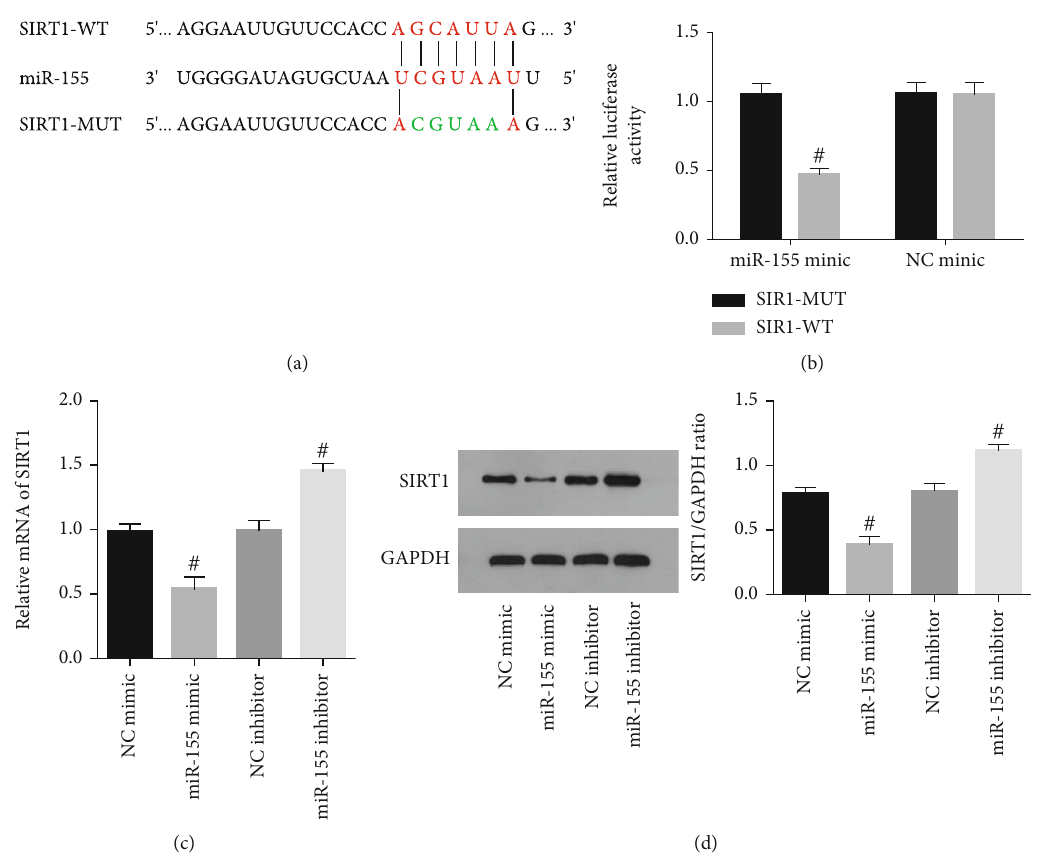
Figure 3: miR-155 directly targeted SIRT1 in podocytes. (a) miR-155 binding site speci fi c for SIRT1. (b) Luciferase activities of HEK-293T cells that overexpressed miR-155 along with either WT-SIRT1 or MUT-SIRT1. # Compared with NC mimic group, P < 0 : 05 . (c, d) SIRT1 expressions in podocyte with miR-155 overexpression or suppression was assessed using real-time PCR and Western blotting analysis. # Compared with NC mimic or inhibitor group, P < 0 : 05